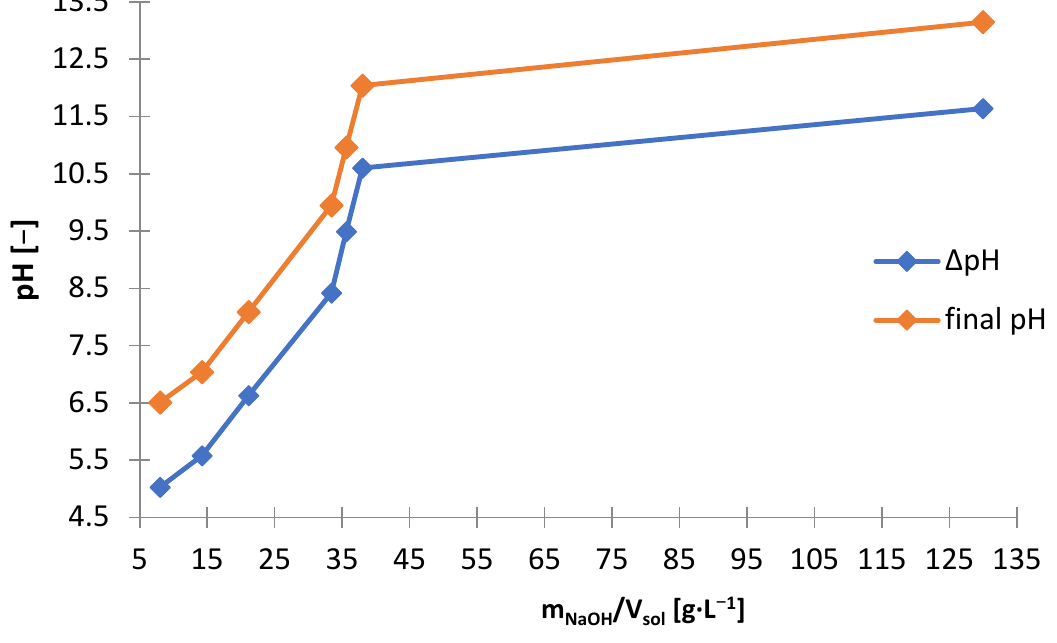
Figure 16. Effect of amount of NaOH (m NaOH /V sol ) on final and change in pH during precipitation from solution after non-selective leaching.